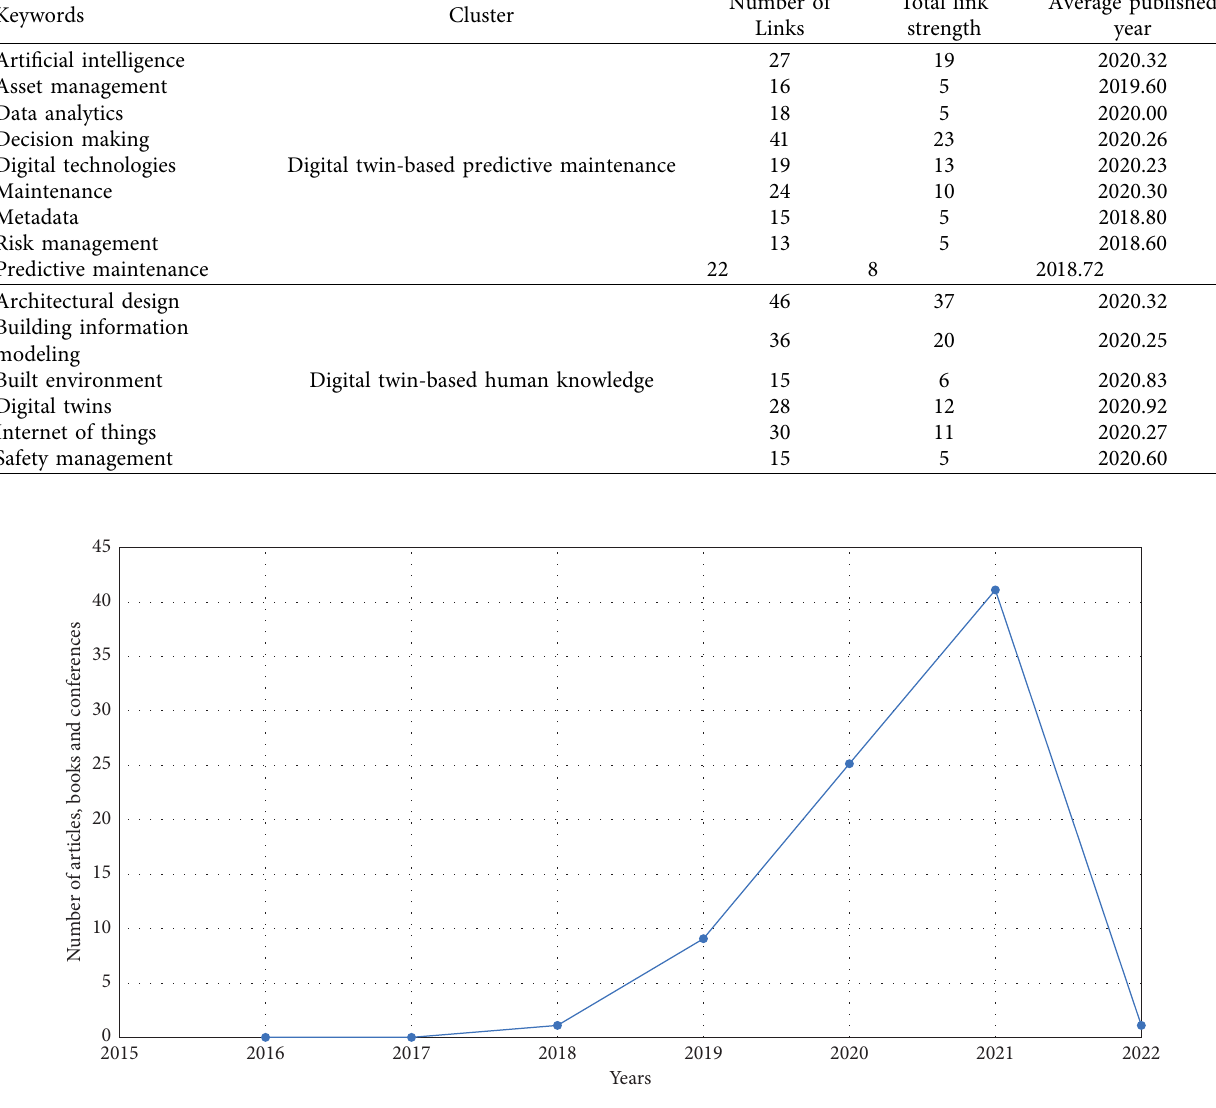
Figure 6: Te number of articles published each year in the AEC-FM industry regarding Digital Twin research from 2016 to